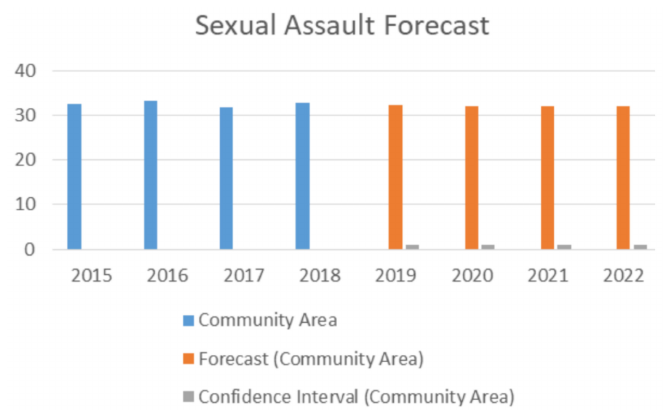
Figure 3. An estimation of future sexual assault cases in the USA